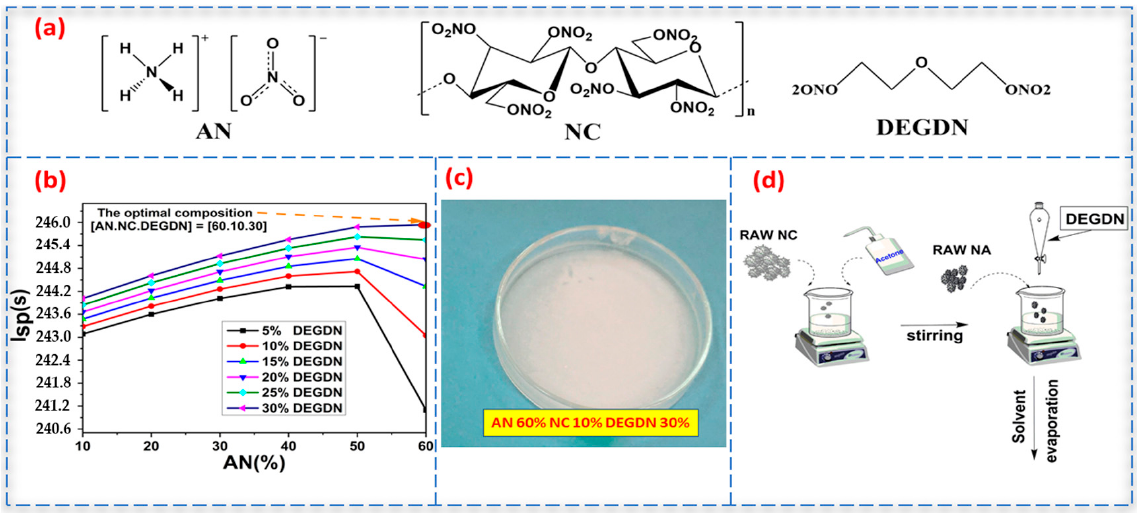
Figure 1. ( a ) Chemical structures of AN, NC, and DEGDN. ( b ) Variation of the specific im- pulse of AN/NC-DEGDN formulation versus the mass fraction of AN. ( c ) AN/NC-DEGDN film. ( d ) Elaboration process of AN/NC-DEGDN